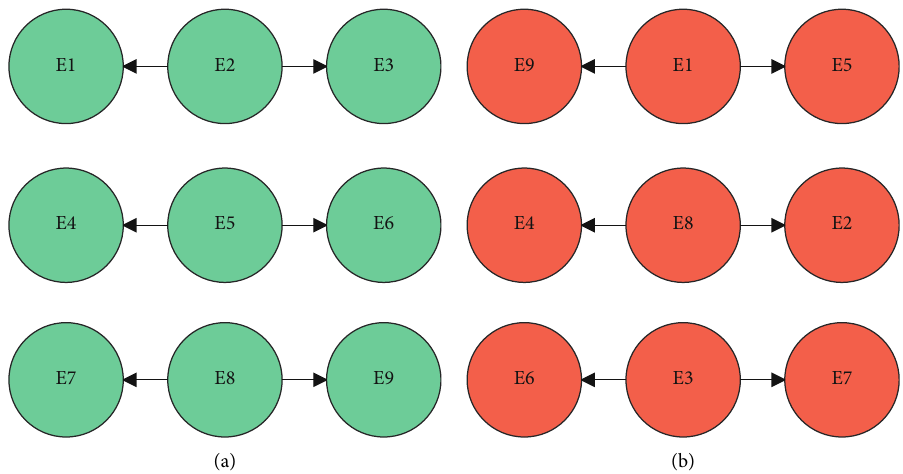
Figure 8: Changes before and after image block scrambling: (a) images block before scrambling; (b) images block after scrambling.